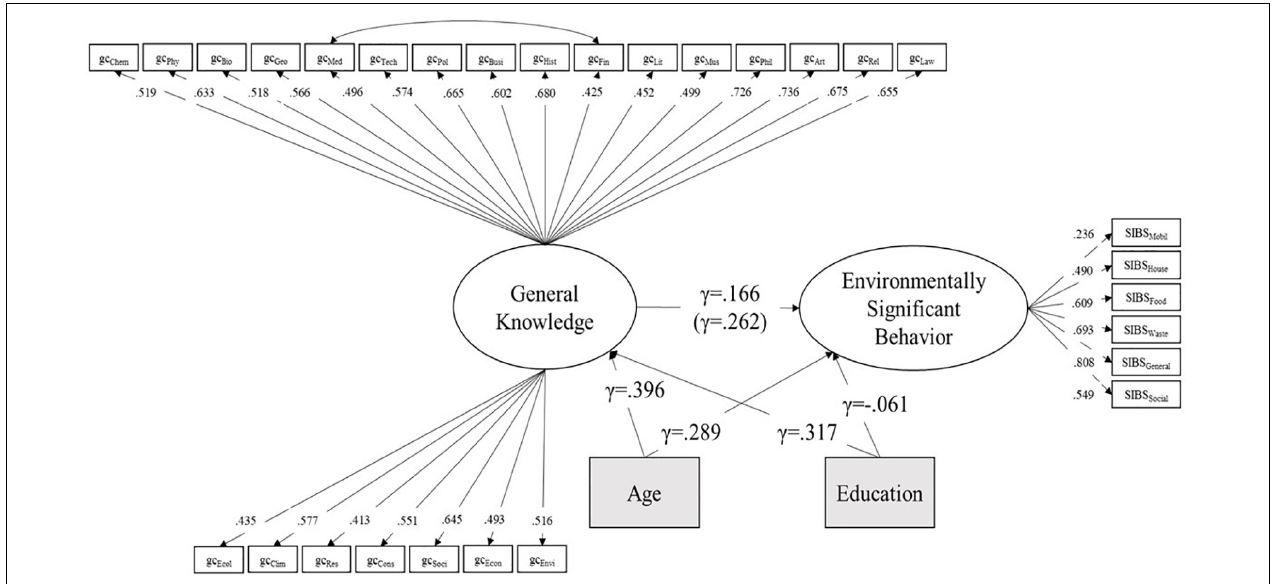
FIGURE 1 | SEM model prediction of environmentally significant behavior through general knowledge and age as common cause. The γ of general knowledge predicting environmentally significant behavior in brackets is the value without including age and education. The value without brackets is the value when including age and